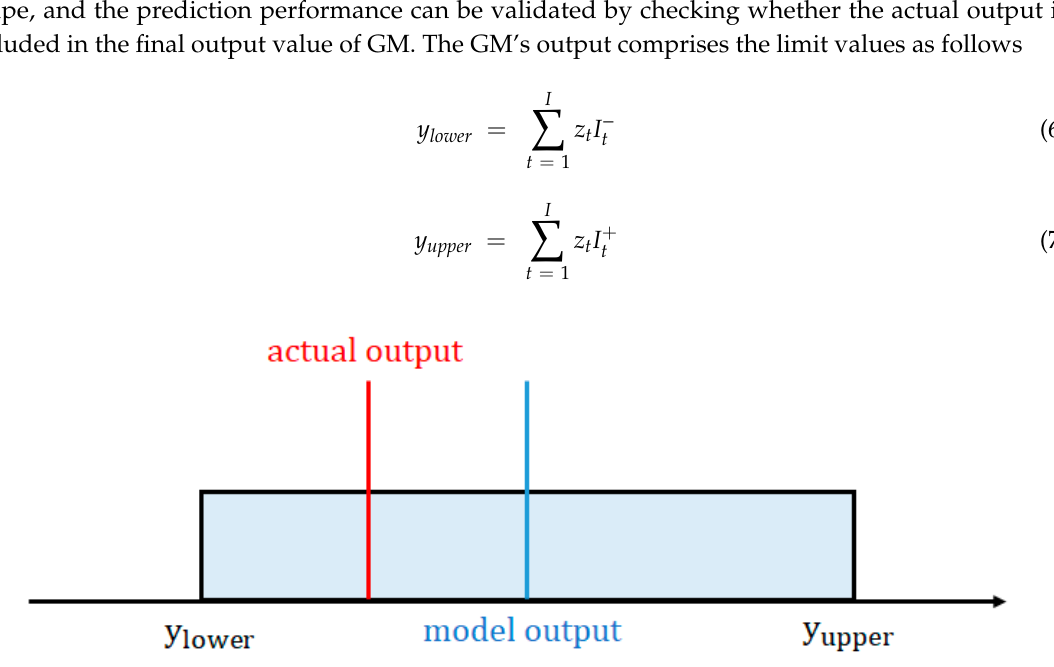
Figure 3. Architecture of interval-based granular model (GM).